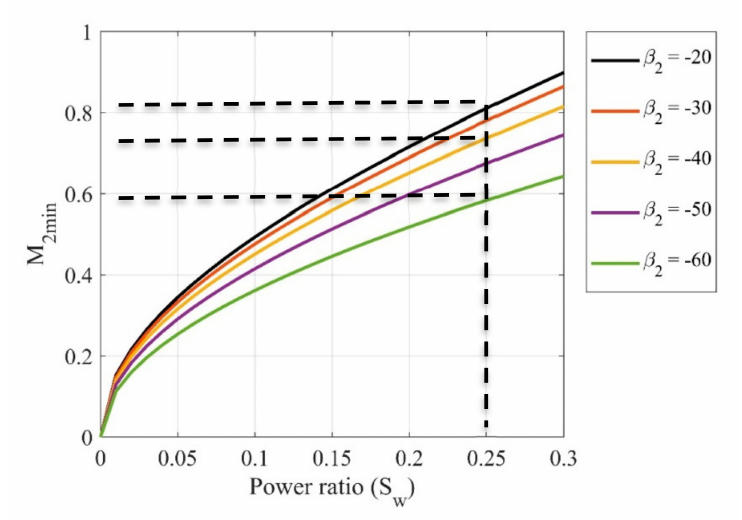
Figure 2. Variation of Mach number with power ratio for di ff erent values of β 2